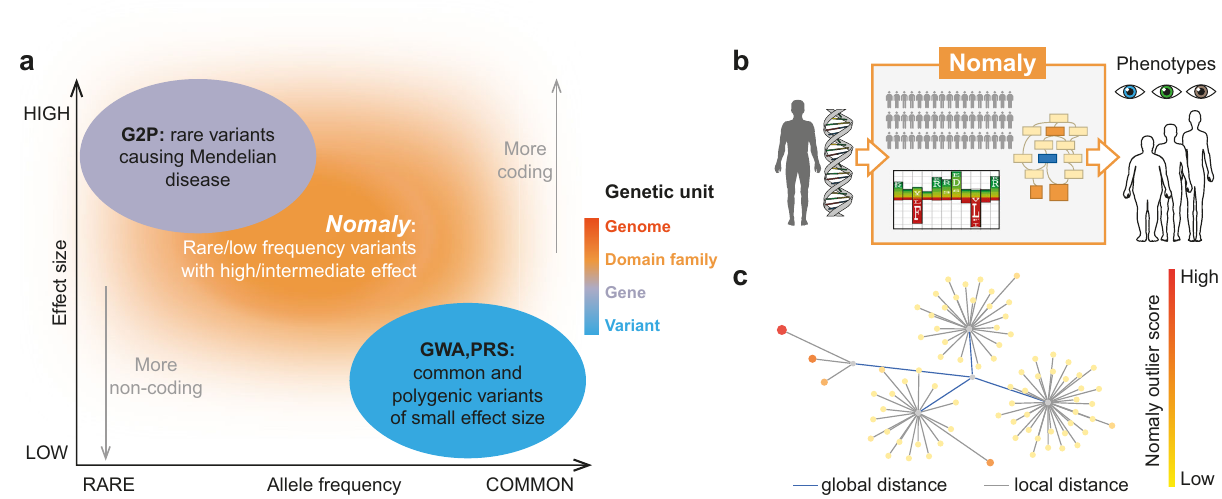
Fig. 1 | Framework incentive and design. a Positioning relative to heritability interpretation from two prevailing genetic association analyses 2 of many. G2P: Gene-to-phenotypedatabases,GWA:Genomewideassociation,PRS:Polygenicrisk scores. The colour bar shows the genetic unit of analysis employed by each method. b Framework overview. The method takes an individual ’ s genetic data as input and produces a list of ontology terms for which the person is a potential outlier.Itusesalargebackgroundofgenomestowhichtheindividualiscompared,